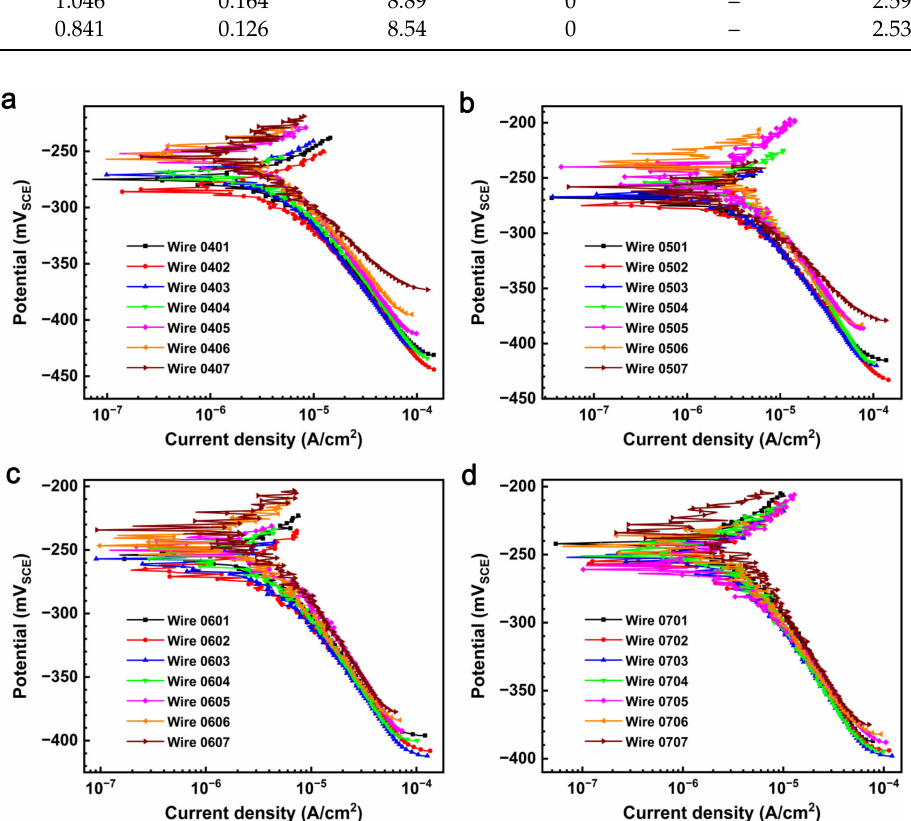
Figure 7. Potentiodynamic polarization curves of the ( a ) 4th, ( b ) 5th, ( c ) 6th and ( d ) 7th column of 90/10 copper–nickel alloy WBE after 168 h impingement at 5 m/s using 1 wt.% NaCl solution without sand